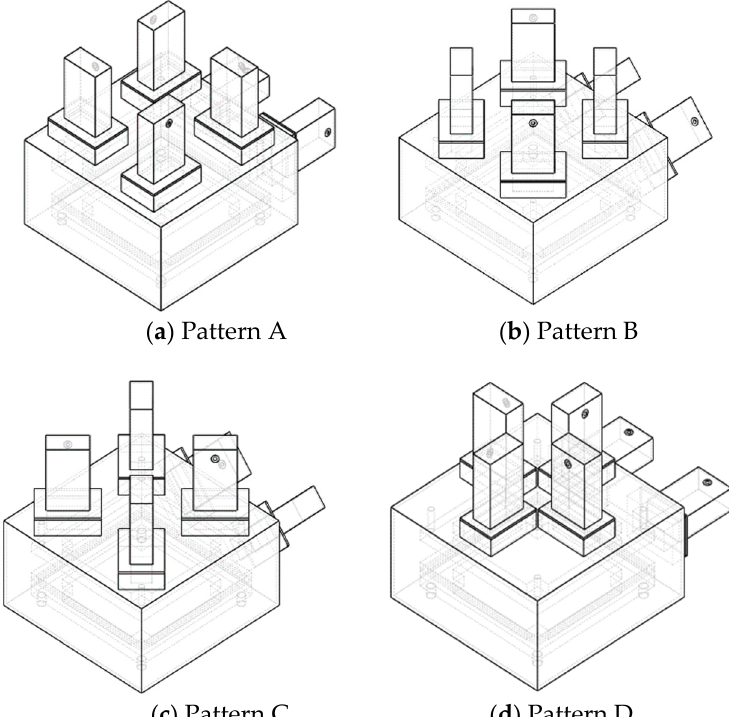
Figure 2. A 6 kW model microwave chamber with four different waveguide patterns.